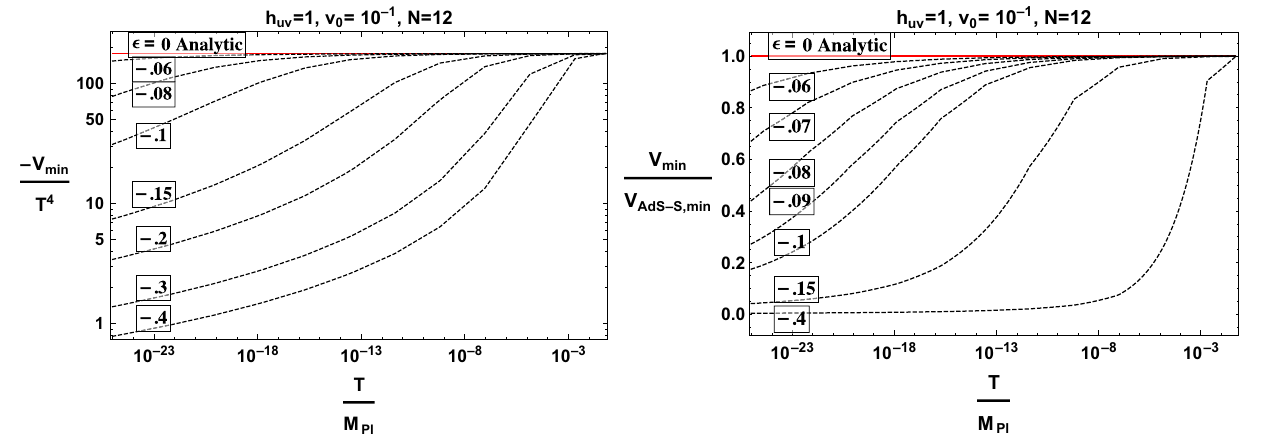
Fig. 4 In this figure, we show the minimum of the free energy func- tion rescaled by the fourth power of the temperature. The temperature is set by the inverse compactification radius of the time coordinate. On the right hand side, for comparison, we give the minimum of the free